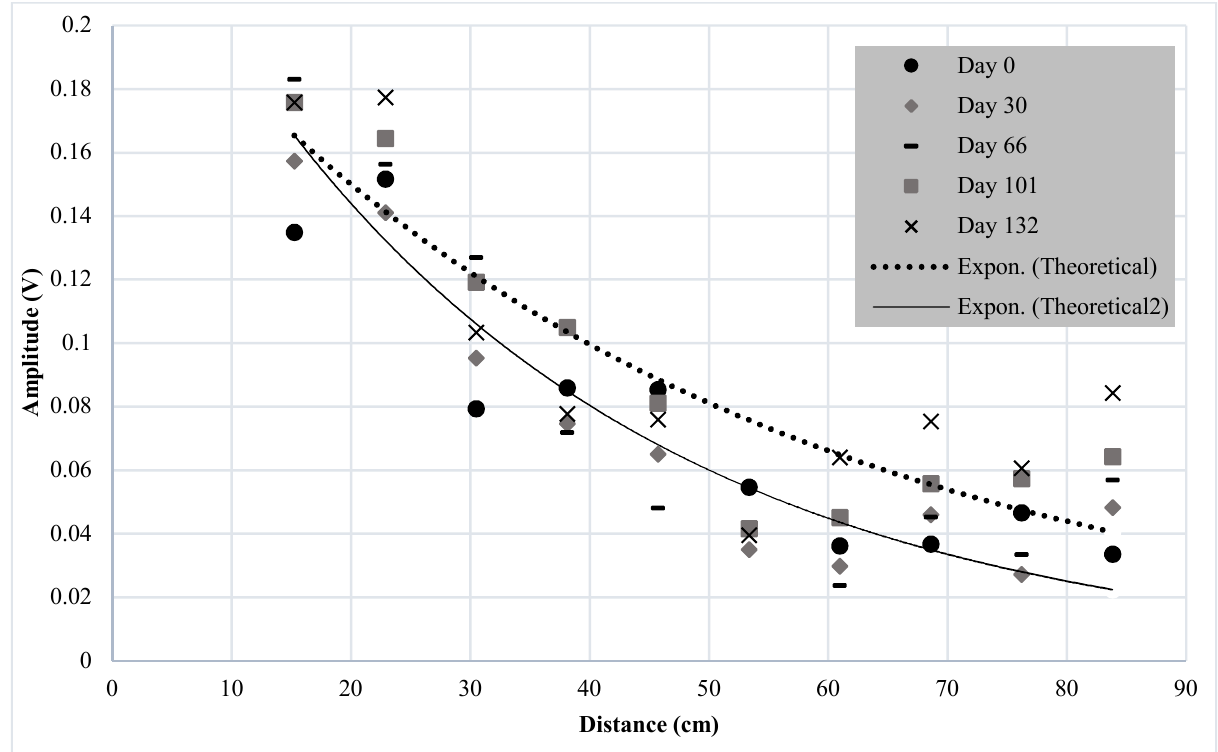
Figure 8. Specimen B—UGWL readings for select days between day 0 and day 132.